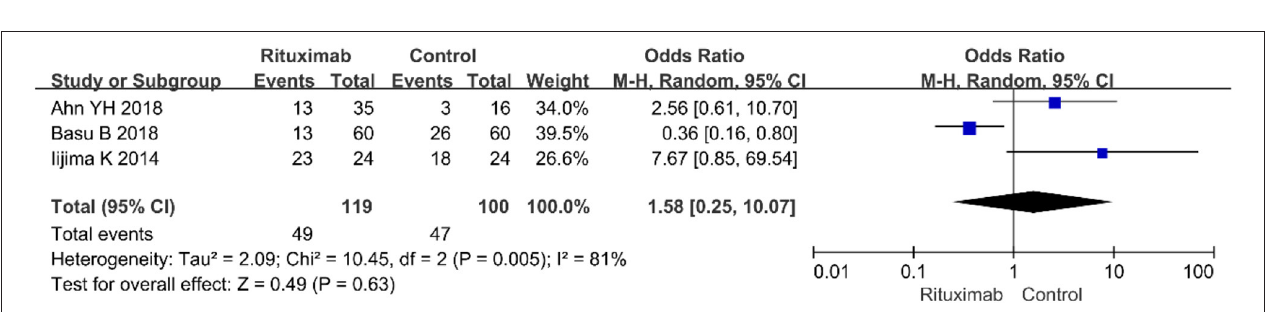
FIGURE 7 | Forest plot showing a meta-analysis of eGFR between rituximab treatment group and control group.